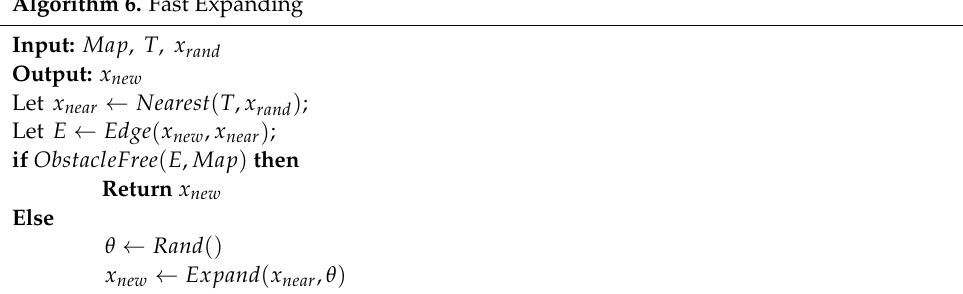
Algorithm 6. Fast Expanding